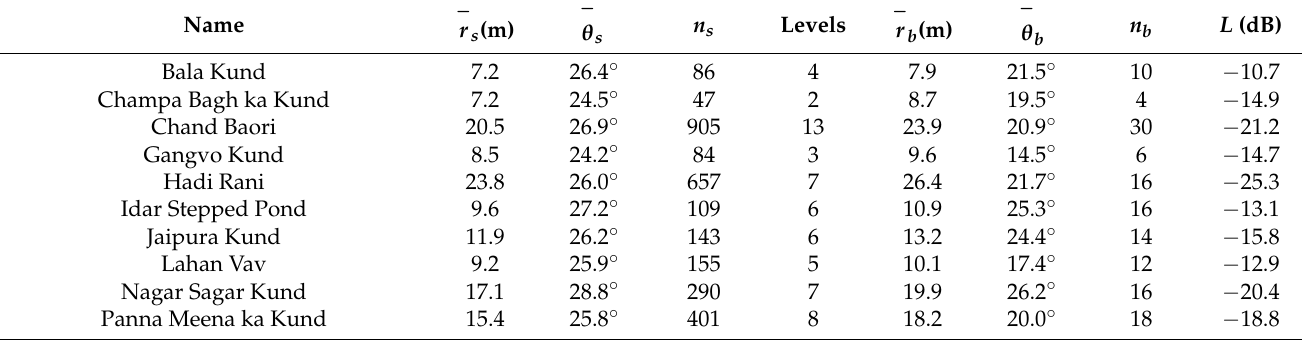
Table A1. Parameters used for simplified retroreflected energy level estimates based on the ten example stepped ponds from Table 1. Symbols: r is the distance of visible retroreflectors, θ is the incidence angle from the trihedron boresight and n is the number of visible reflectors. Subscripts: s denotes small reflectors, and b denotes big reflectors. ‘Levels’ is the number of levels in the well. The table also shows the estimated retroreflected energy level results for the cases ( L ) averaged over the 1–4 kHz octave bands. Note that the average values of the distance and incidence angle are provided here, but the underlying individual values are used in the estimations of retroreflected energy.